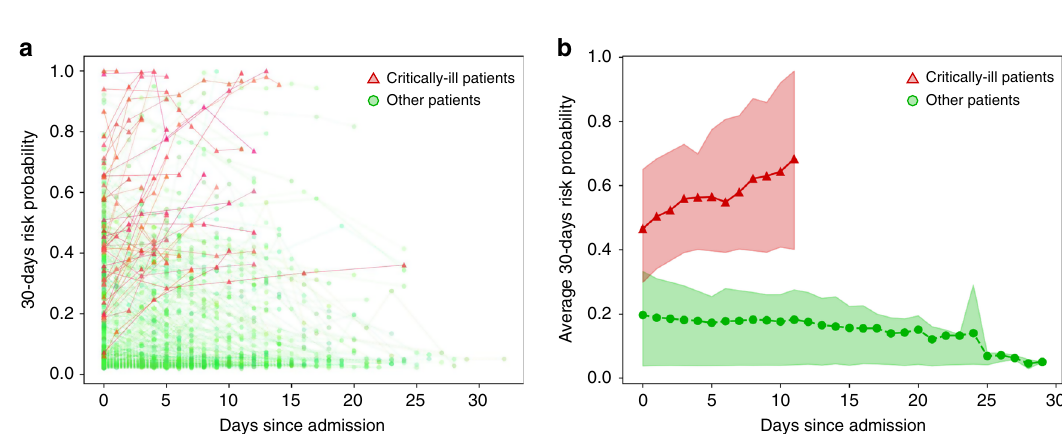
Fig. 2 Trend of 30-days critically ill risk probability in the follow-up visit after admission. Red lines with triangle markers are critically ill patients. Green lines with circle markers are other patients. a Visualization of trend of each individual. Each marker indicates a follow-up exam. For better visualization, line color has been slightly disturbed for each patient. b Average trend for different groups of patients. Colored area corresponds to the 25% and 75% of the risk Fig. 1c, d show the results of the entire external validation datasets and Ex3 datasets that excluded patients with more than three missing clinical features out of the ten required. The C-index of the entire dataset for the Wuhan, Hubei, and Guangdong cohorts were 0.878, 0.769, and 0.967, respectively. In the Ex3 dataset, the C-index for these cohorts were 0.890, 0.852, and 0.967, respectively.